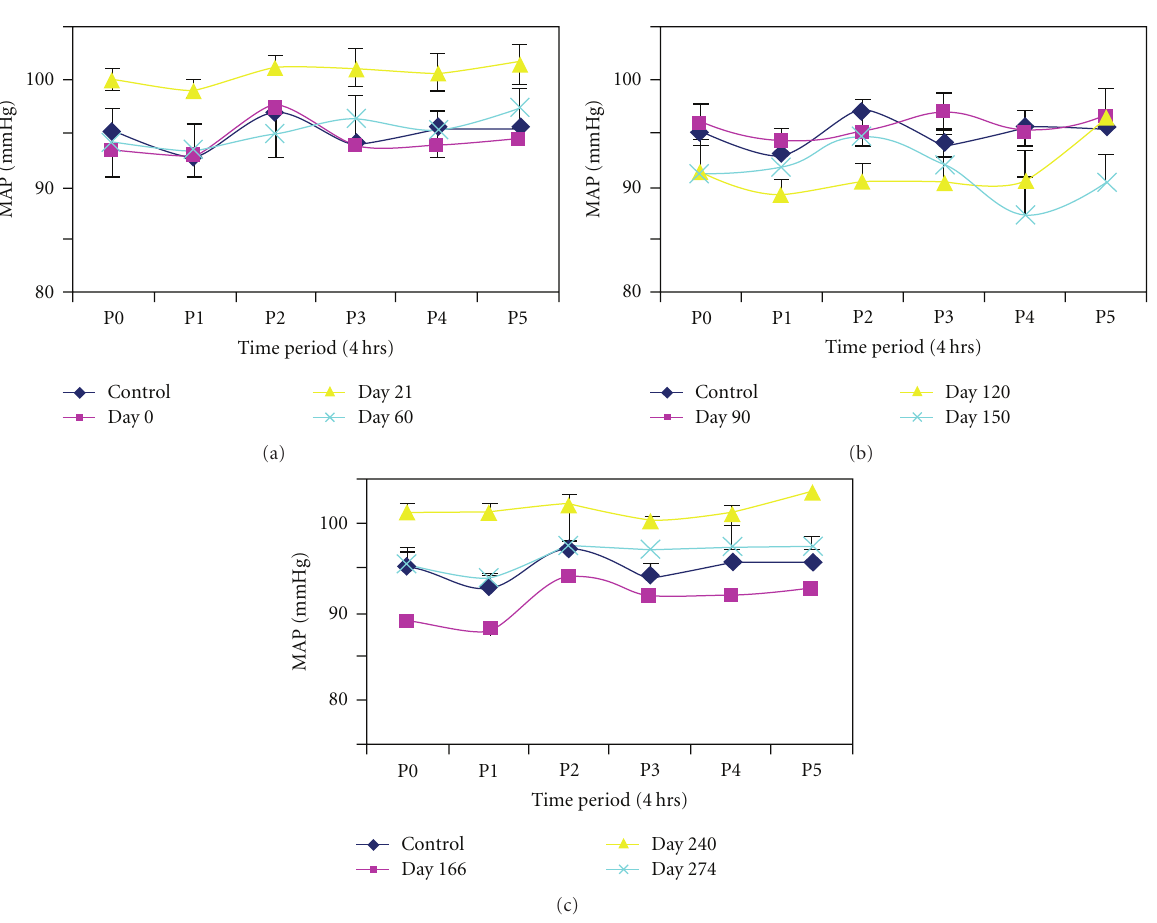
Figure 1: Compressed recording showing heart rate and blood pressure variations with the light and dark cycles in BBDP rats, over ten days. Note the circadian pattern with increased HR and BP over the dark periods, typical of nocturnal animals.